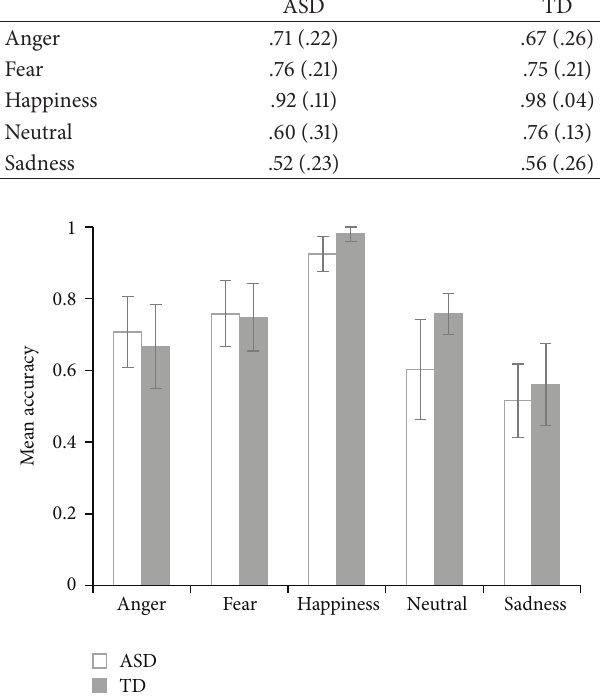
Figure 2: Mean performances for both participant groups on the different original expressions (error bars represent 95% confidence intervals of the